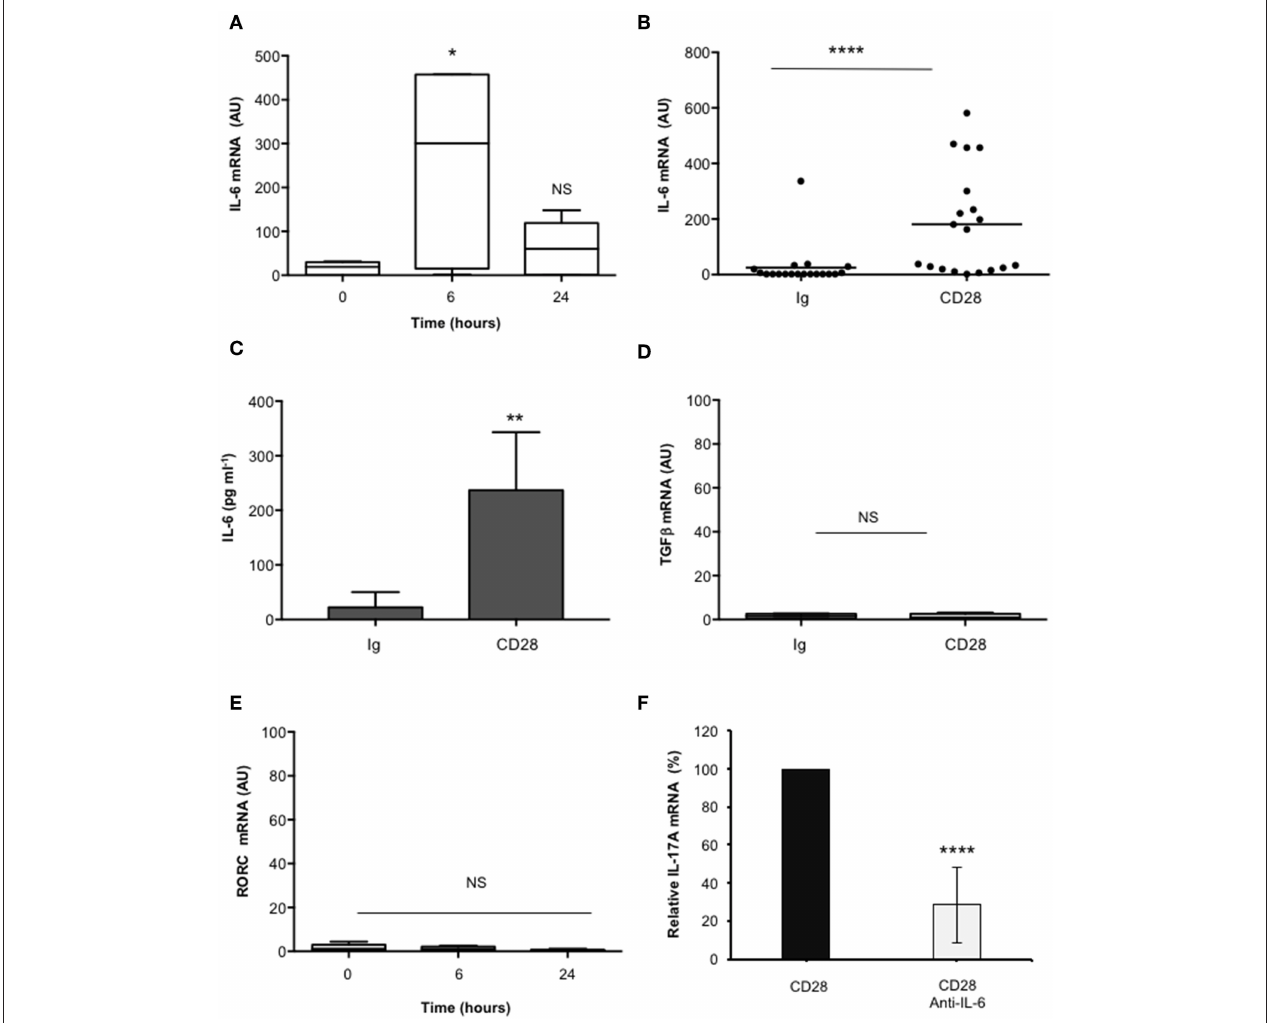
FIGURE 2 | CD28-induced IL-17A gene expression depends on IL-6. (A) Kinetic analysis of IL-6 gene expression in CD4 + T cells from HD ( n = 5) stimulated for the indicated times with isotype control Ig or anti-CD28.2 Abs. IL-6 mRNA levels were measured by real-time PCR and values, normalized to GAPDH, expressed as AU. Lines represent median values and statistical significance was calculated by Mann-Whitney test. Median values: 0h = 19, 6h = 300, 24h = 60. (B) IL-6 mRNA levels of CD4 + T cells from HD ( n = 19) stimulated for 6h with isotype control Ig or anti-CD28.2 Abs. Lines represent median values (AU) and statistical significance was calculated by Mann-Whitney test. Median values: Ig = 1.12, CD28 = 163.1. (C) CD4 + T cells from HD subjects ( n = 5) were stimulated for 24h with isotype control Ig or crosslinked anti-CD28.2 Abs. IL-6 levels in culture supernatant were measured by ELISA. Bars show the mean ± SD. Statistical significance was calculated by Student t -test. Mean values ± SD: Ig = 22 ± 12 pg ml − 1 , CD28 = 236 ± 47 pg ml − 1 . (D) TGF β mRNA levels of CD4 + T cells from HD ( n = 4) stimulated for 6h with isotype control Ig or crosslinked anti-CD28.2 Abs. Lines represent median values (AU) and statistical significance was calculated by Mann-Whitney test. Median values: Ig = 1.5, CD28 = 0.95. (E) RORC mRNA levels of CD4 + T cells from HD ( n = 8) stimulated for the indicated times with isotype control Ig or crosslinked anti-CD28.2 Abs. Lines represent median values (AU) and statistical significance was calculated by Mann-Whitney test. Median values: 0h = 1.1, 6h = 1.2, 24h = 0.4. (F) IL-17A mRNA levels in CD4 + T cells from HD ( n = 5) stimulated for 24h with isotype control Ig or anti-CD28.2 Abs in the presence of 10 µ g ml − 1 isotype control or neutralizing anti-IL-6 Abs. The values were normalized to GAPDH and fold inductions over isotype control Ig-stimulated cells were calculated. IL-17A